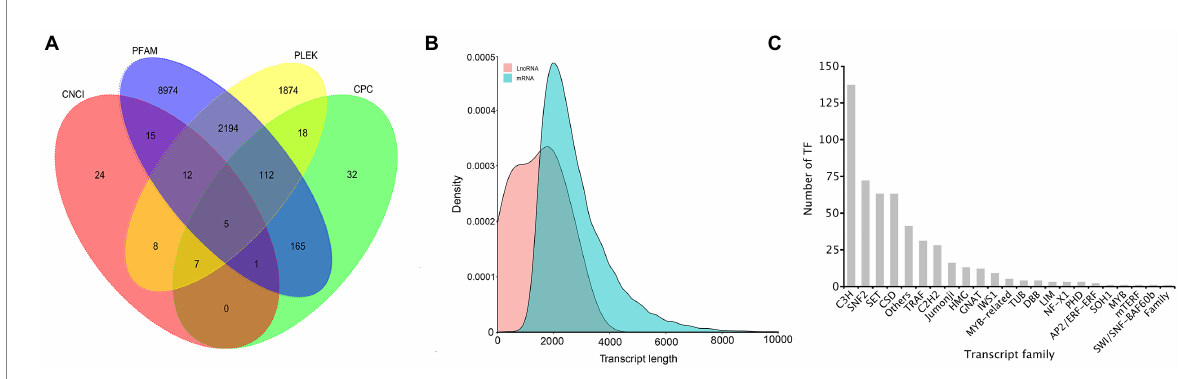
FIGURE 7 The identification of lncRNAs and the transcript family of the A. sanguinea transcriptome. (A) The venn diagram of the number of lncRNAs predicted by CPC2, CPAT, PLEK, and CNCI. (B) Density and length distributions of mRNAs and lncRNA in A. sanguinea . (C) Transcript families in the A. sanguinea full-length transcriptome.